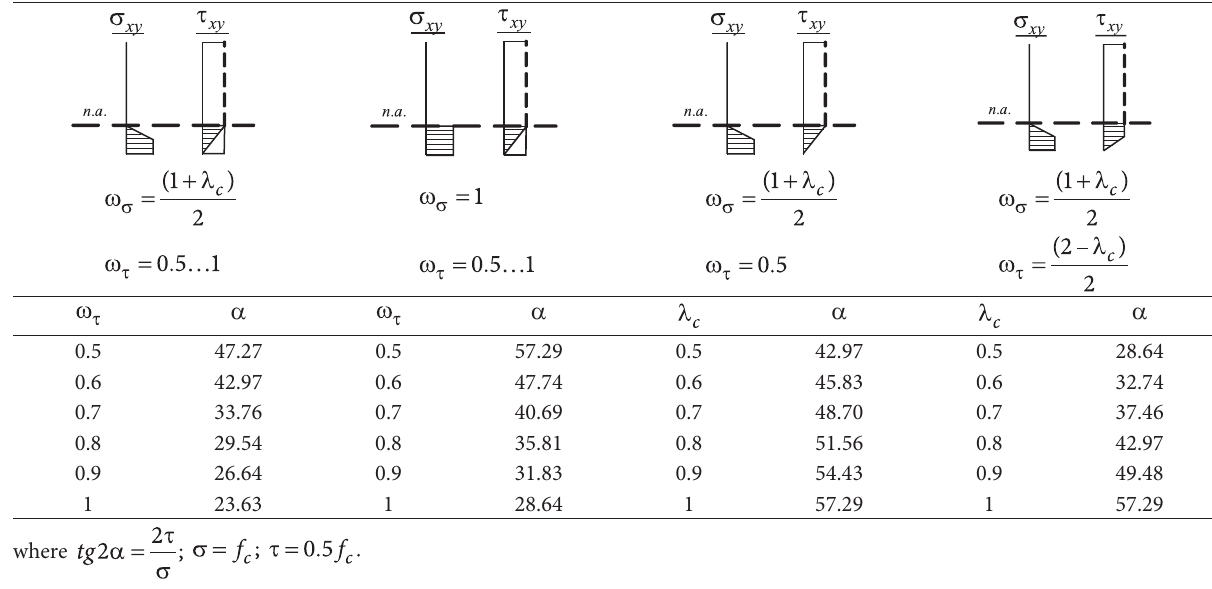
Table 2. Punching carrying capacity results of experimental slabs Series